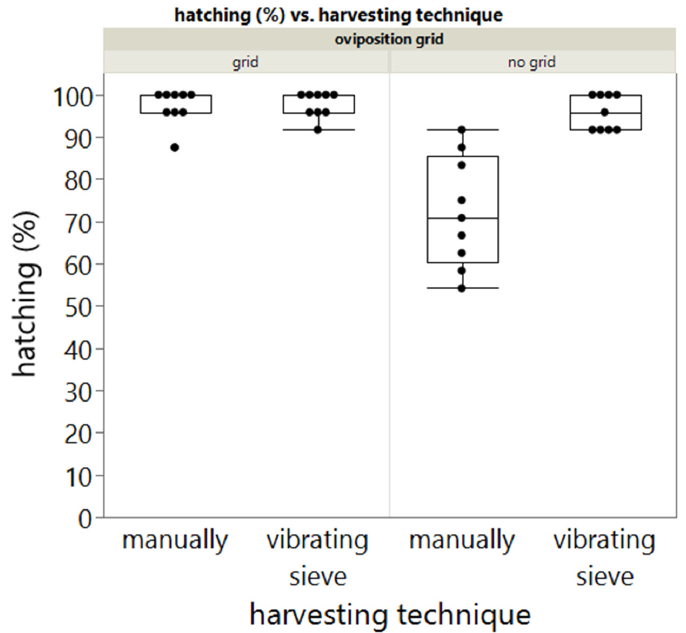
Figure 2. Boxplot representing the effect of harvesting method and presence of grid on egg hatching. Points represent individual measurements.